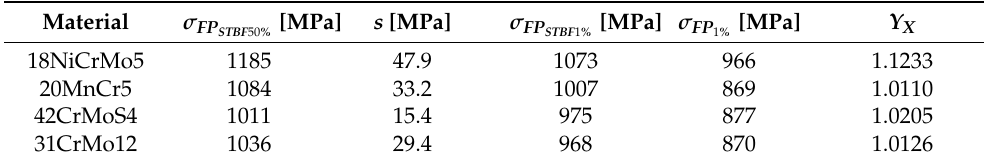
Table 6. Test results relative to the 4 mm-module